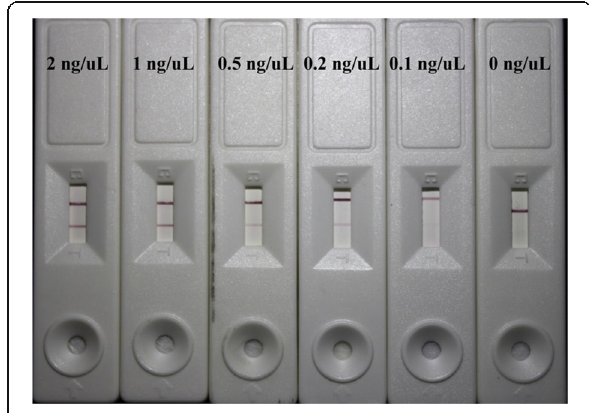
Fig. 5 The specifity and sensitivity of the LFTS. ( B : BoNT-negative serum; N : BoNT/B-spiked serum; 1 ~ 5 : 0.2, 2, 20, 200, and 2 ng/mL BoNT/A-spiked sera